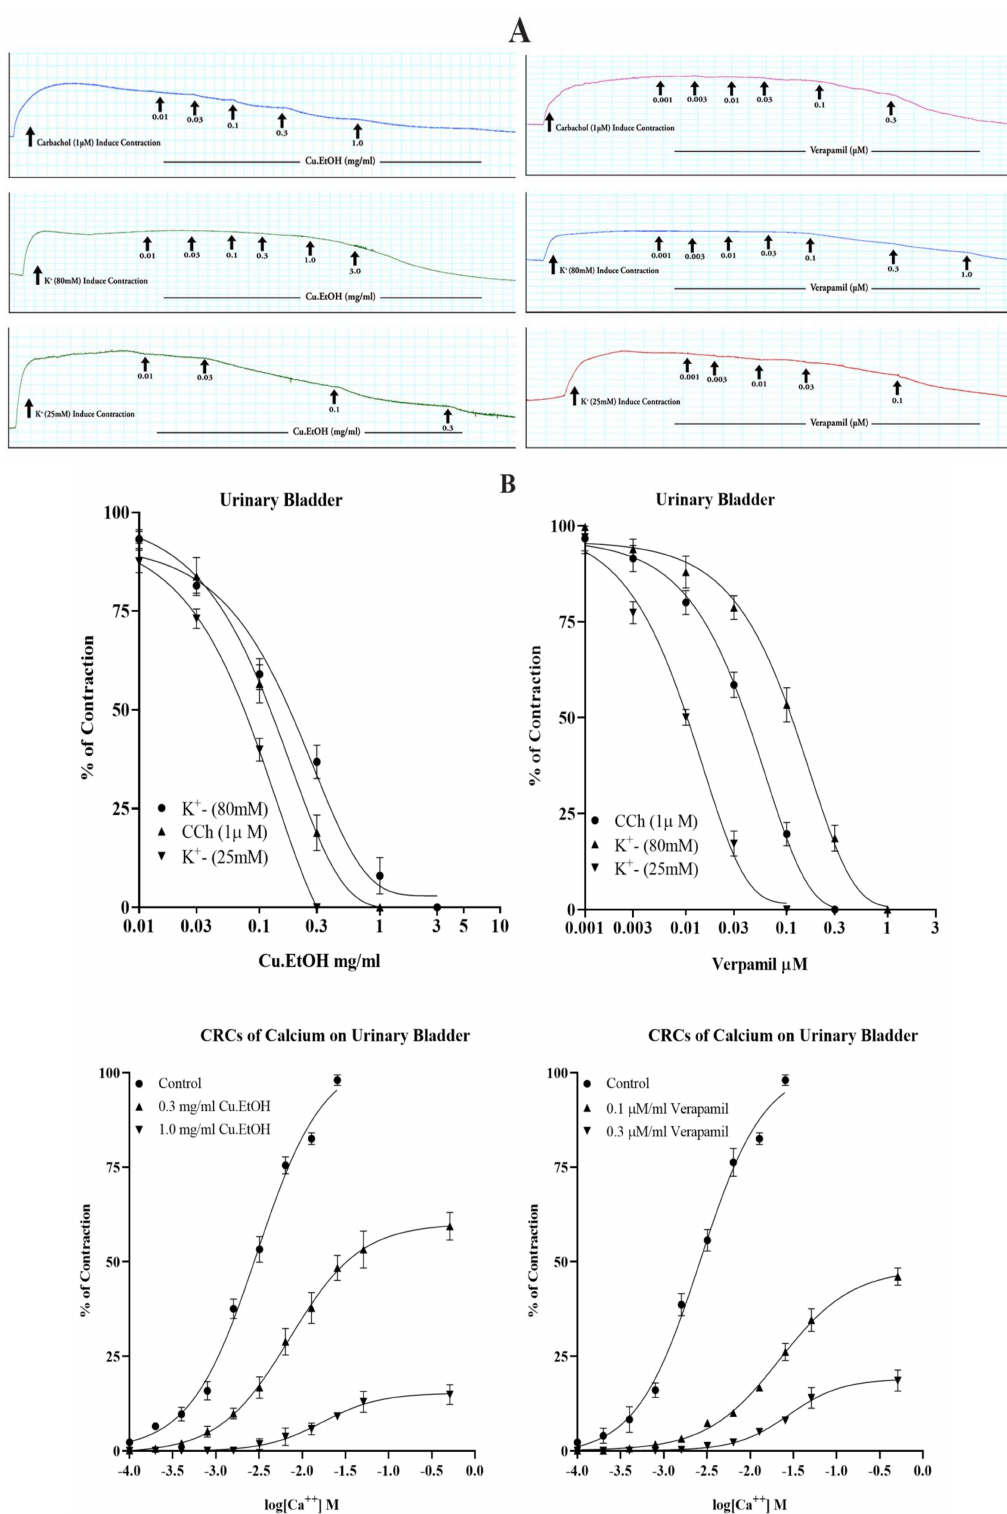
Figure 10. Effect of C. sativus seeds extracts (Cu.EtOH) and verapamil on urinary bladder preparations in respect of spontaneous, K + (80 mM), carbachol, and K + (25 mM) contraction concentration-response curves. ( A ) Physiological responses of Cu.EtOH ( B ) sigmoidal dose-response curve of Cu.EtOH on urinary bladder preparations (Values are expressed as Mean ± SD, data was analyzed by sigmoidal dose-response